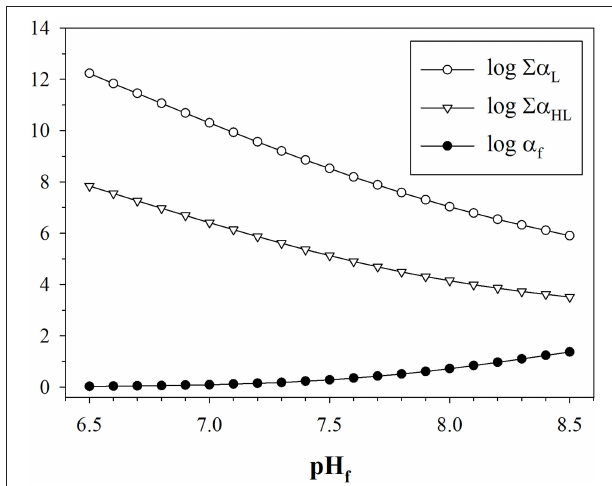
FIGURE 4 | Dependence of the side-reaction coefficients log P α L , log P α HL , and log α f (Table 9) on seawater pH (free scale). The pH dependence of Mg and Ca free-ion concentrations, which mostly reflects their complexation with sulfate, is negligible and was